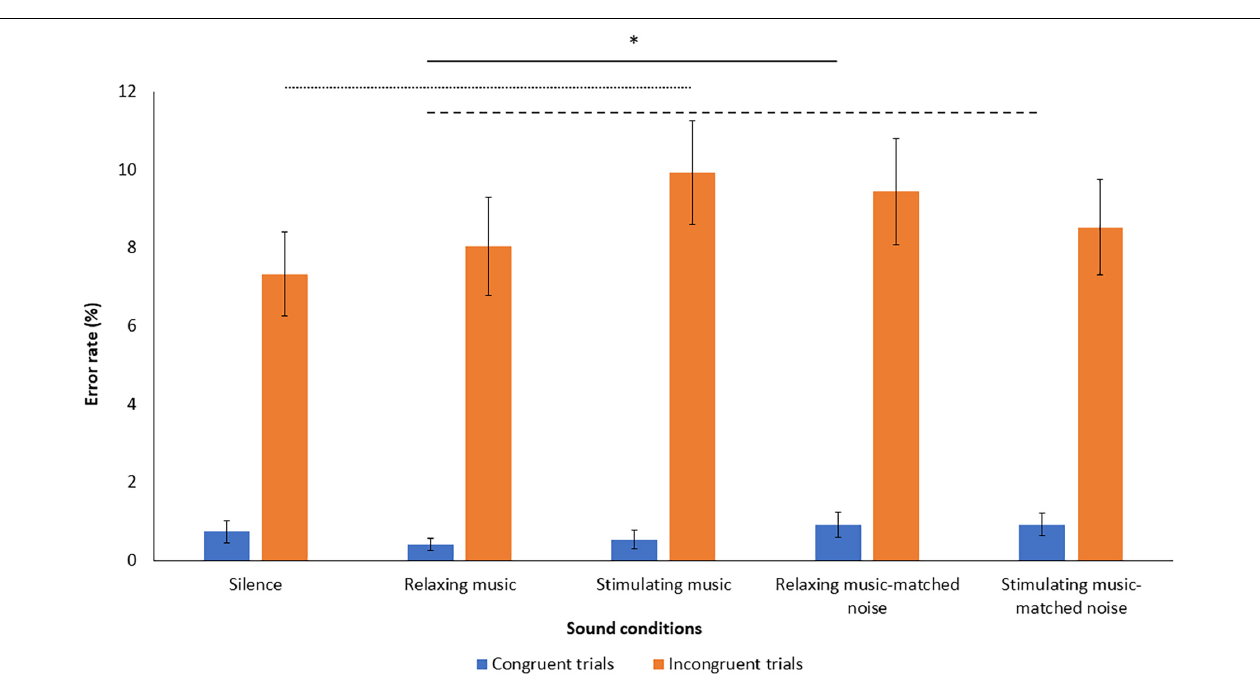
FIGURE 3 | Mean error rate on incongruent and congruent trials for each sound condition. Graph shows standard errors. ∗ p < 0.05. - - - p = 0.07. ...... p =